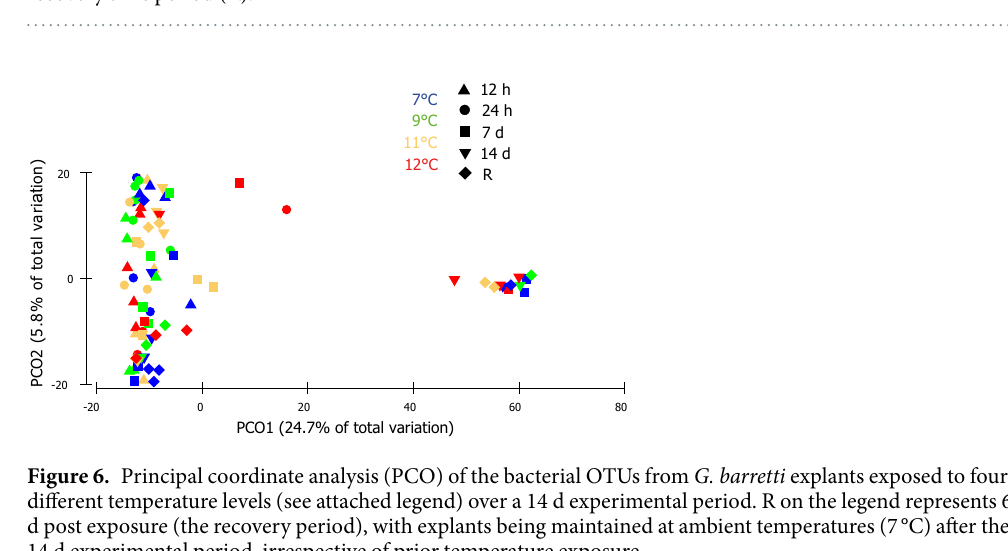
Figure 5. Left panel –Mean percentages (%) of cells with destabilised lysosomal membranes ± S.E. (n = 5) of G. barretti explants exposed to four different temperature levels (7 °C–Black bar, 9 °C–Dark grey bar, 11 °C– Light grey bar & 12 °C–White bar) over a 14 d experimental period. R on the x-axis is respiration at 65 d post exposure (the recovery period), with explants being maintained at ambient temperatures (7 °C) after the 14 d experimental period, irrespective of prior temperature exposure. Right panel –Interaction plot of estimated marginal means of lysosomal membrane destabilisation calculated for each temperature (7 °C–Black circles, 9 °C–Dark grey triangles, 11 °C–Light grey squares & 12 °C–White diamonds) at each exposure day and recovery time period (R).